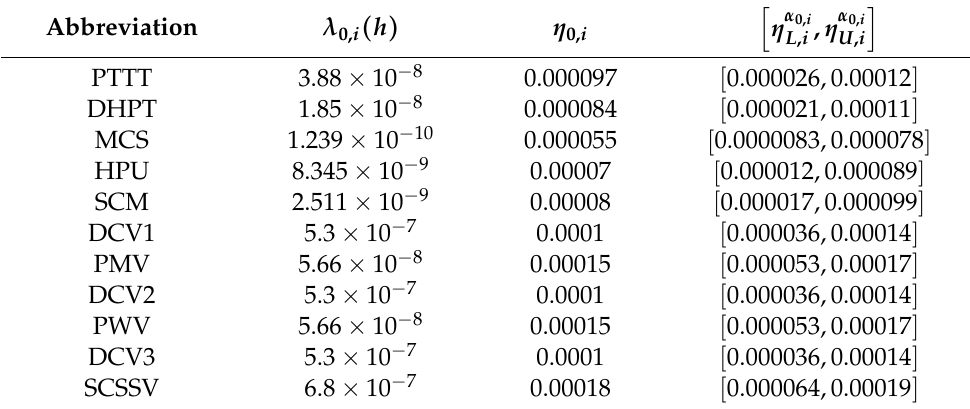
Table 2. Failure rate and failure rate cumulated parameter of each equipment in subsea emergency shutdown